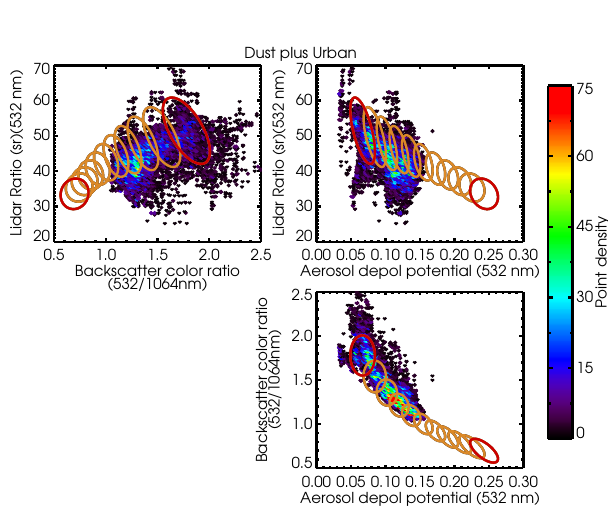
Fig. 3. Aerosol intensive parameters measured by HSRL-1 on 15 March 2006 in Mexico City and surrounding areas. All data below 4kma.s.l. having 532nm aerosol extinction greater than 0.05km − 1 are shown. The three panels illustrate three different combinations of two of the intensive parameters: 532nm aerosol li- dar ratio, backscatter color ratio (532 / 1064nm) and 532nm aerosol depolarization potential (see text for definition). The measurements are shown as individual points, color coded by point density in the 2-D space with warmer colors indicating higher point density (in ar- bitrary units). The red ellipses represent two-sigma covariance for pure dust and urban pollution (see text) and the orange ellipses in- dicate mixtures of the two with a range of mixing